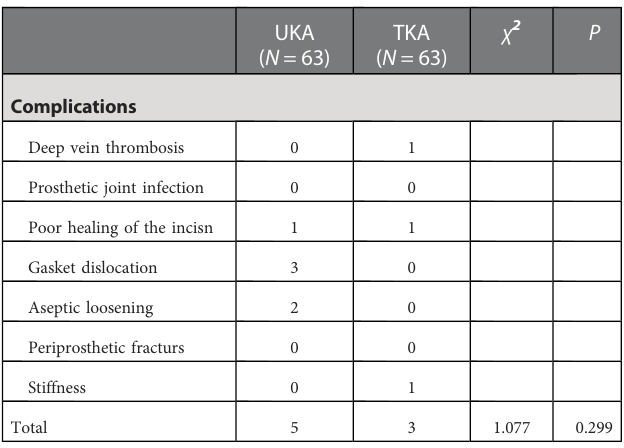
TABLE 3 HSS, JFS and KOOS scores in two groups.